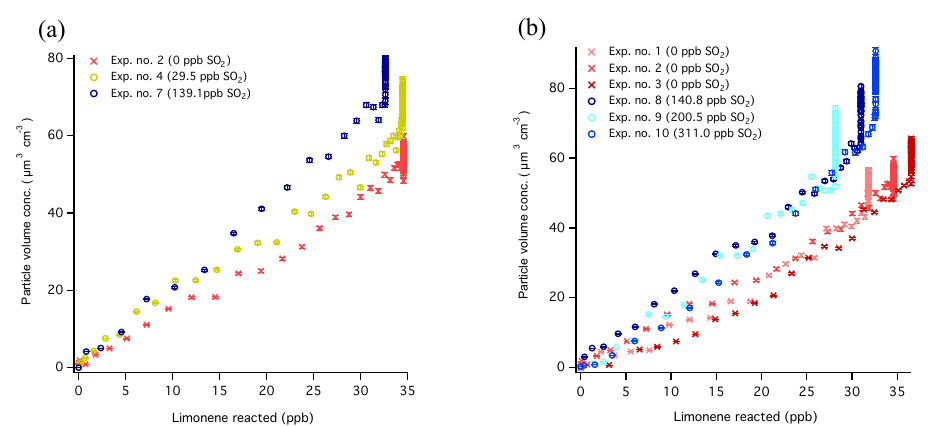
Figure 2. Growth of particle volume concentration as a function of limonene consumption under dry conditions. Particle concentration increased with increasing SO 2 injection concentration (0, 30 and 139ppb) under dry conditions (a) . The enhancement reached a plateau as more SO 2 (>140ppb) was injected (b)